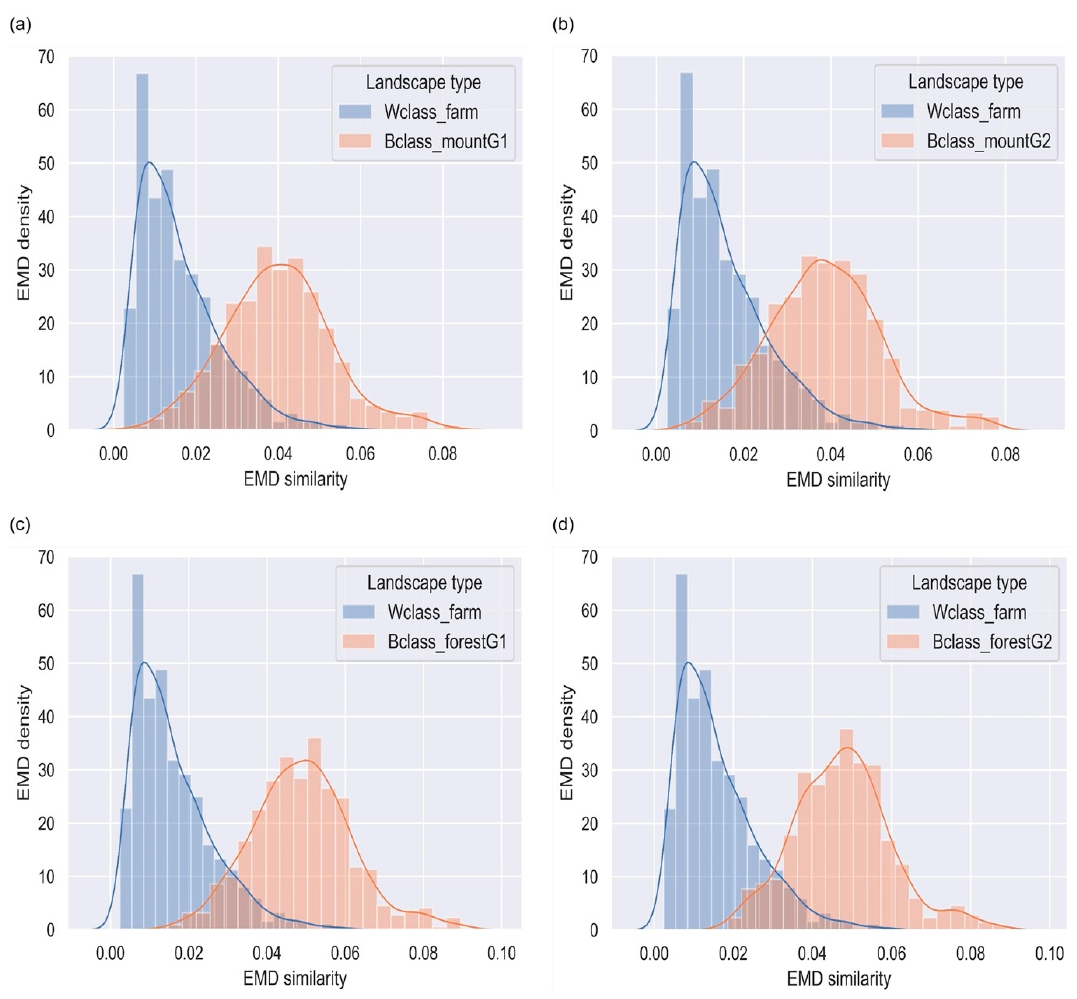
Figure 12. Landscape similarity comparison. Wclass_farm denotes within-farm landscape similarity. ( a , b ) Bclass_mountG1 and Bclass_mountG2 are distributions resulting from comparing farm landscapes with mountains. ( c , d ) Bclass_forestG1 and Bclass_forestG2 are distributions generated by comparing farm landscapes with forests.